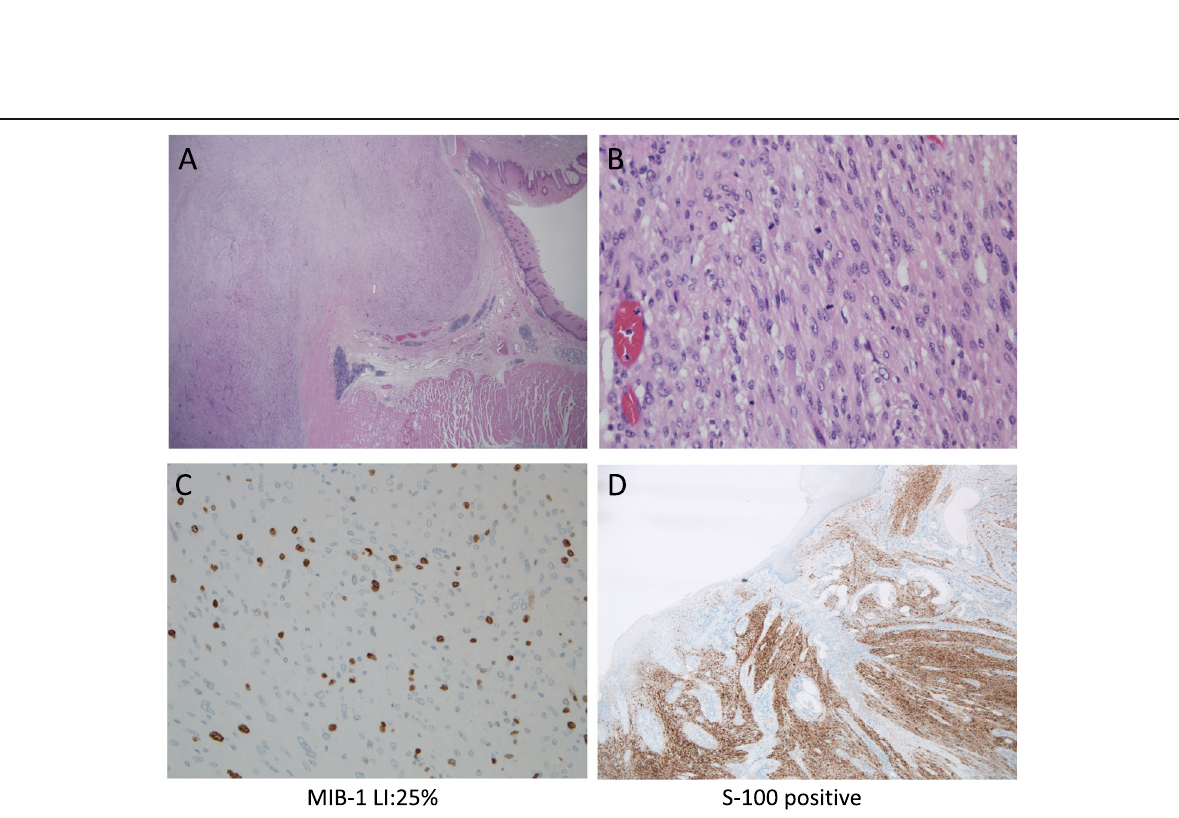
Fig. 5 a , b Histopathological findings. The pathological specimen revealed that spindle cells with different-sized nuclei were mixed throughout the tissue. Some regions showed nuclear polymorphism or a storiform pattern, and locally, there were approximately 7 mitoses/10 HPFs. The margin was relatively clear, but spindle-shaped tumour cells infiltrated the surrounding interstitium and basal myoepithelium, and the patient was diagnosed with malignant peripheral nerve sheath tumour (MPNST). c Immunostaining showed MIB-1-positive staining. The MIB-1 LI was approximately 25%. d Immunostaining showed S-100-positive